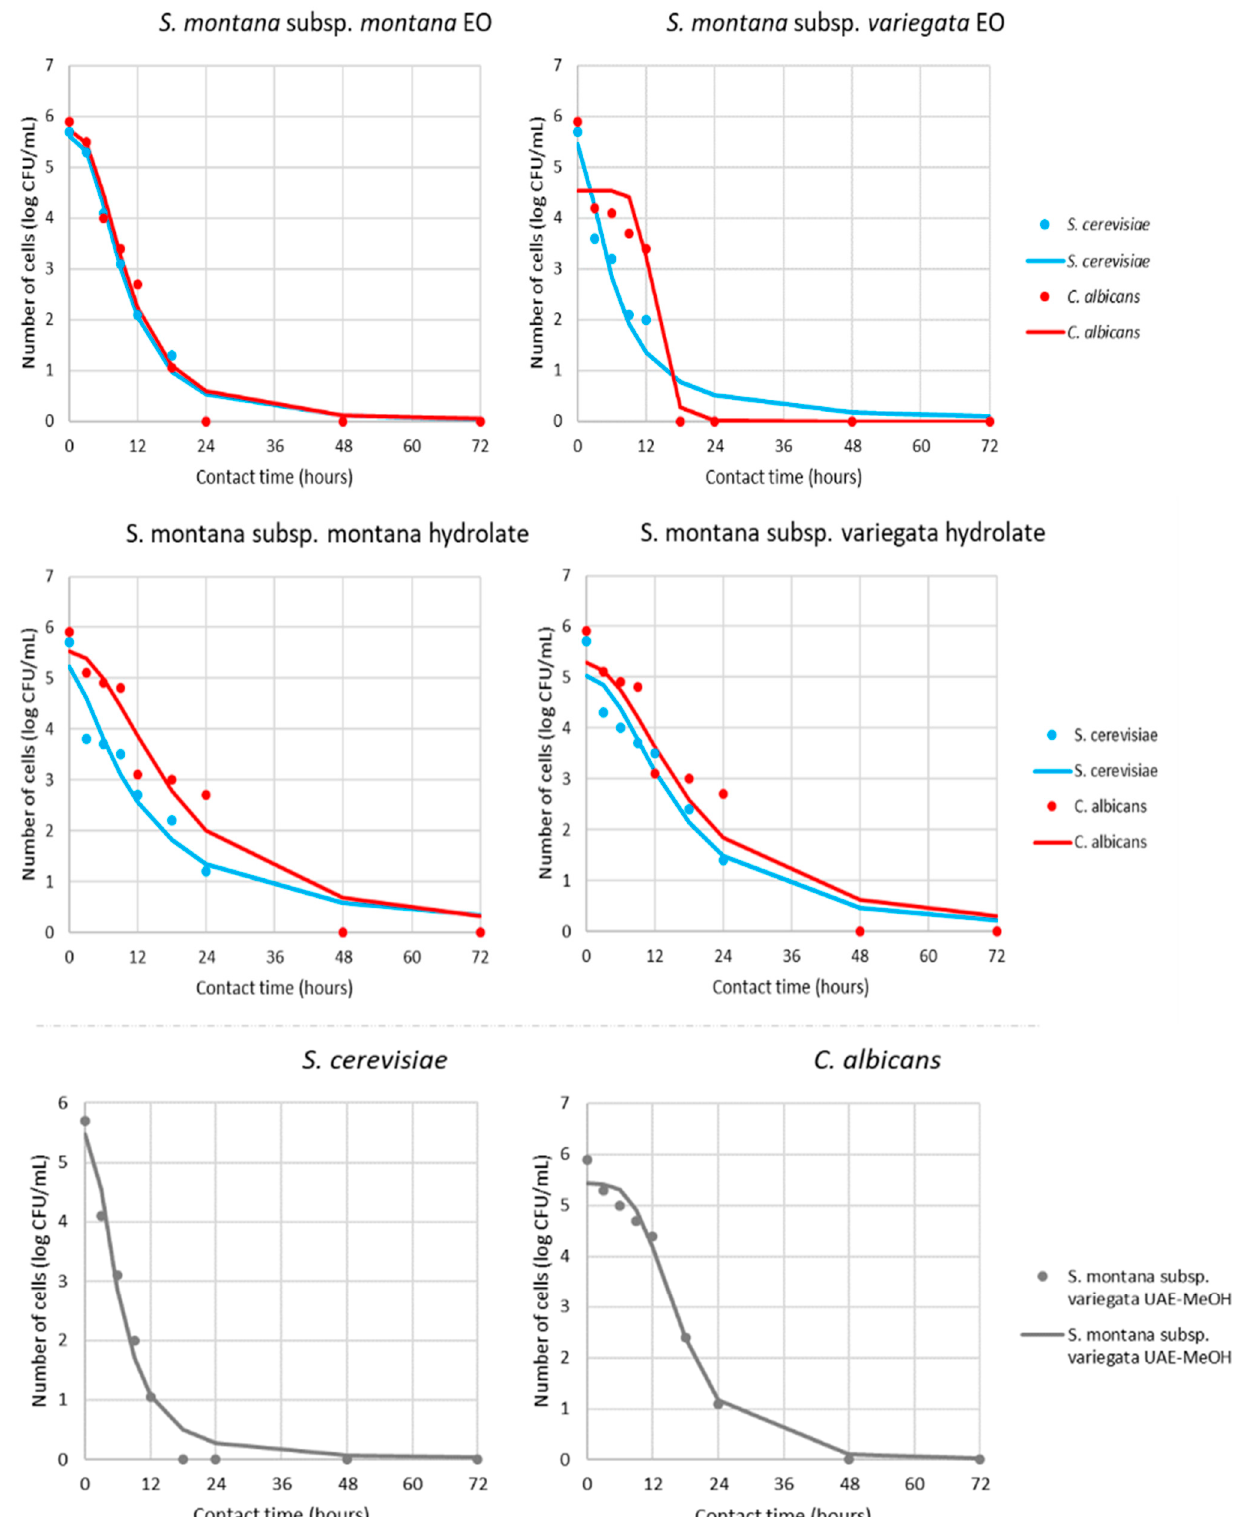
Figure 5. Time–kill kinetics of yeast growth in presence of MICs of antimicrobials (markers signify the experimental data; lines indicate predictive results).